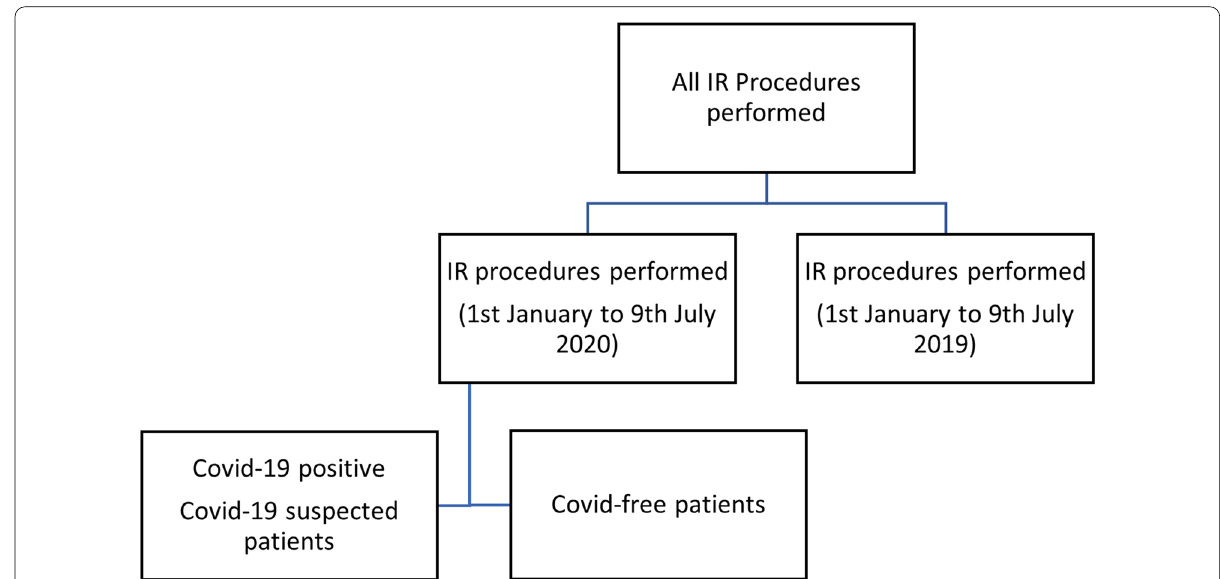
Fig. 1 Flow diagram: flow diagram describing the recruitment of patients into the study. The study period was chosen to include the earliest official notice of COVID-19’s emergence by the World Health Organization up till the appropriate incubation period after the nation’s eight-week circuit breaker. The corresponding pre-pandemic period in 2019 was chosen as it contained the traditional annual lull periods due to major cultural holidays in the country